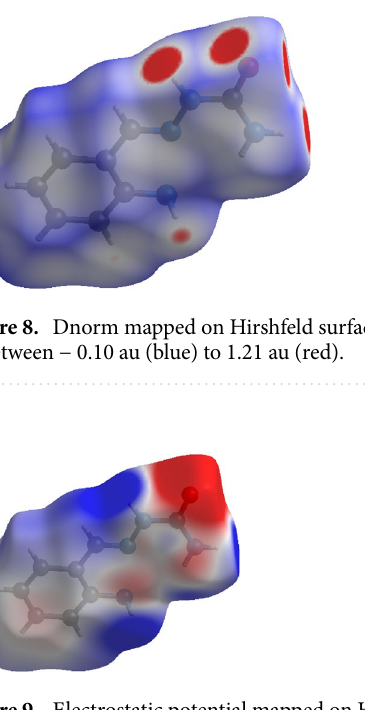
Figure 9. Electrostatic potential mapped on Hirsh field surface (different orientation) with ± 0.030 au. Blue region corresponds to positive electrostatic potential and red region to negative electrostatic